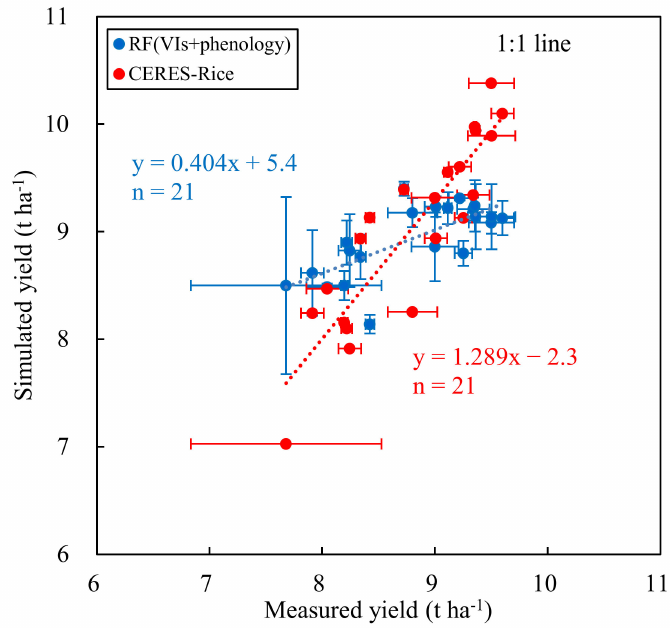
Figure 8. Measured vs. simulated yield from the CERES-Rice model and the optimal RF model for 21 cultivars in 2019. The dots represent the mean values of 21 cultivars with three replicates. The horizontal and vertical error bars refer to ± one standard deviation associated with each mean, respectively, in the measured yield distributions and prediction distributions of the optimal RF model for each cultivar. The error bar in the CERES-Rice model was not presented